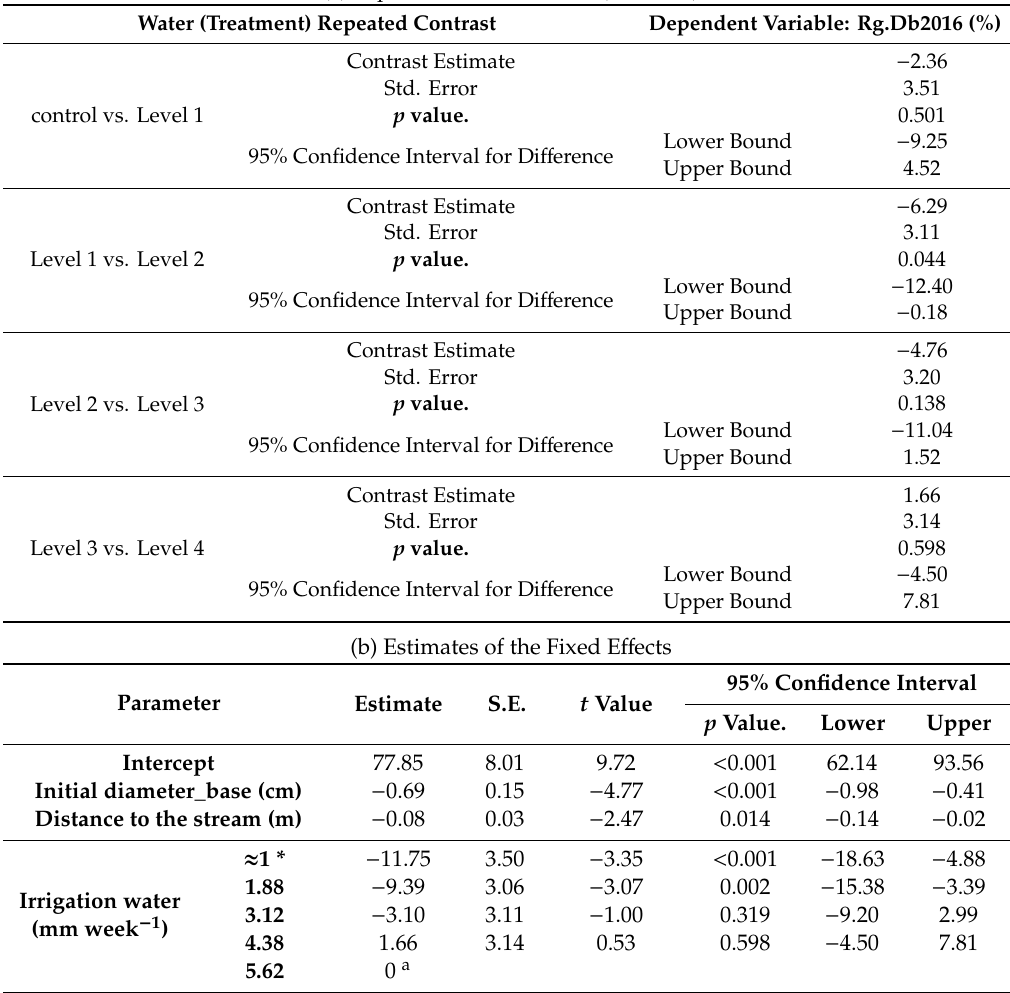
Table A4. Generalized linear model (G.L.M.) on the relative diameter growth at the base (Rg.Db2016 %), in the experimental plot after the irrigation period (Summer 2016). ( a ) Repeated contrast Results (K Matrix), ( b ) Estimates of the Fixed E ff ects.